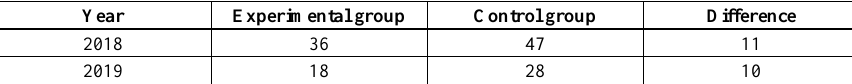
Table 3. Number of applicants rejections %